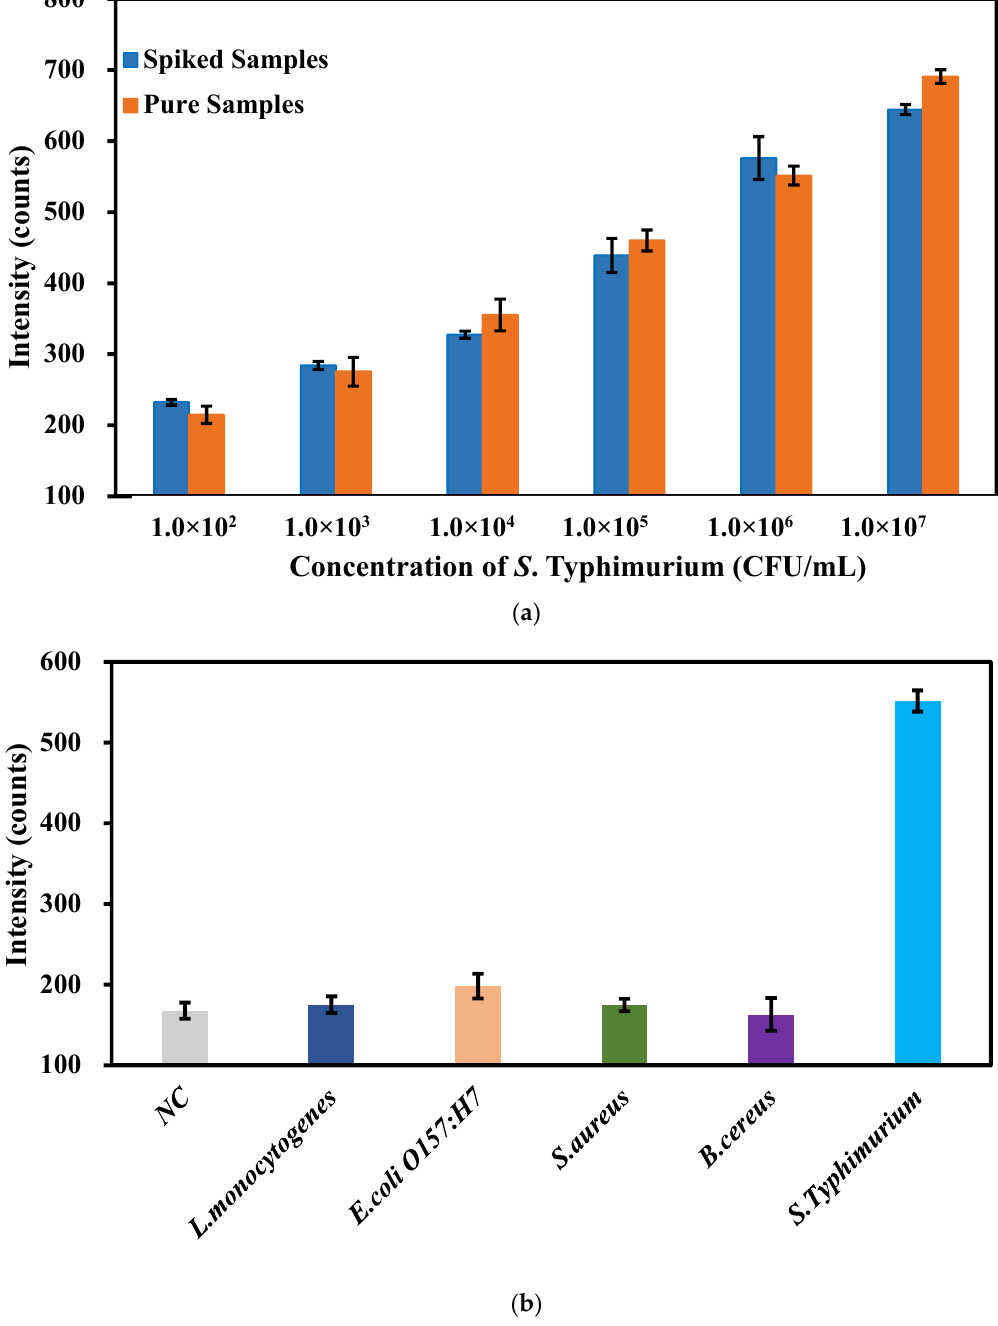
Figure 5. ( a ) Detection of chicken samples spiked with Salmonella Typhimurium (N = 3); ( b ) Detection of L. monocytogenes , E. coli O157:H7, S. aureus , B. cereus , and S . Typhimurium at the same concentration of 10 5 CFU/mL, and the negative control (N = 3).